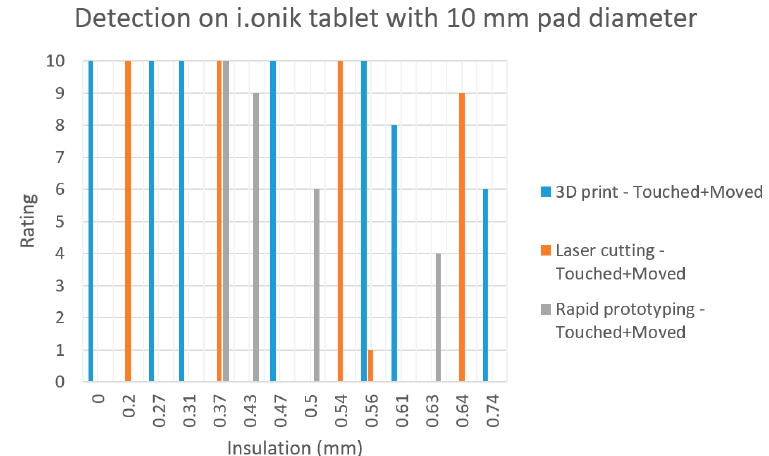
Figure 16. Detection performance (“Rating”) of different marker types with varying insulation layer using the large markers on the i.onik tablet. Contrary to the previous figures, these results show the interaction “Touched and Moved”.